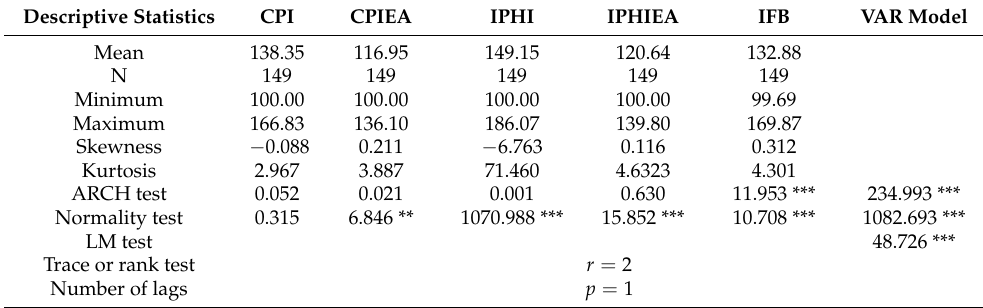
Figure 13. Slovenian price index in the hospitality industry I ( 1 ) . Data vector January 2000 to May 2012 (Great Depression). Table 1. Descriptive statistics of nominal price indices (base period January 2000), data vector for